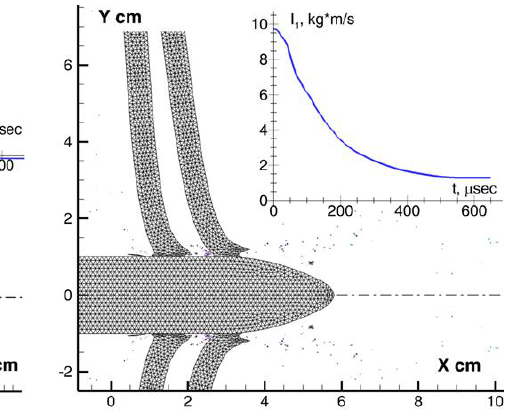
Fig. 3. The position of the hard striker in two- layer steel barrier with the contact of the layers at time t = 500 μ s at the impact velocity of 310 m/s (cross section along the axis with the difference grid), the graph in the right corner is the behavior of the momentum in time.